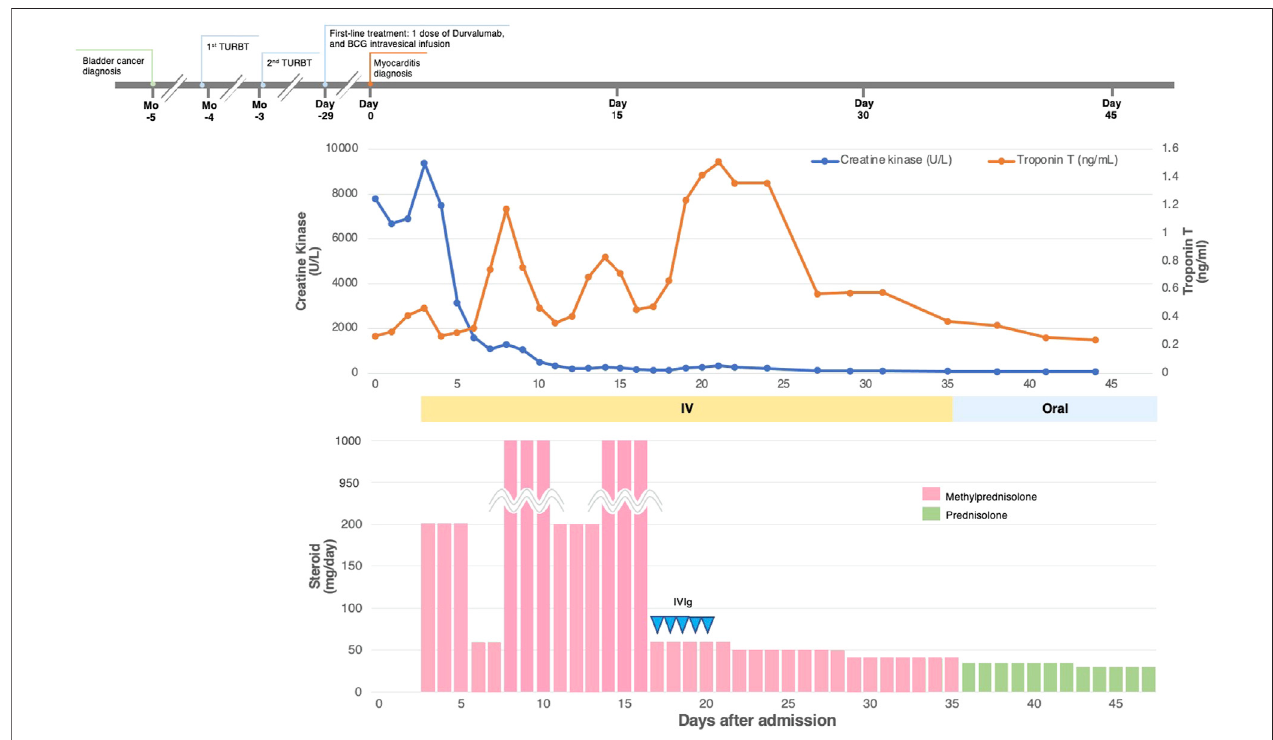
FIGURE 4 | Clinical course and changes in CK and troponin in case